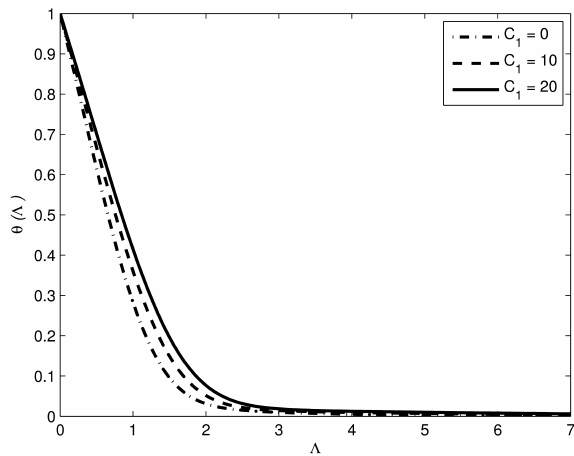
Figure 9: Effect of η on − H ( Λ ) keeping ζ = 0.2 , C 1 = C 2 = C 3 = 20 , Pr = 6.8 , Br = 1 and Re =